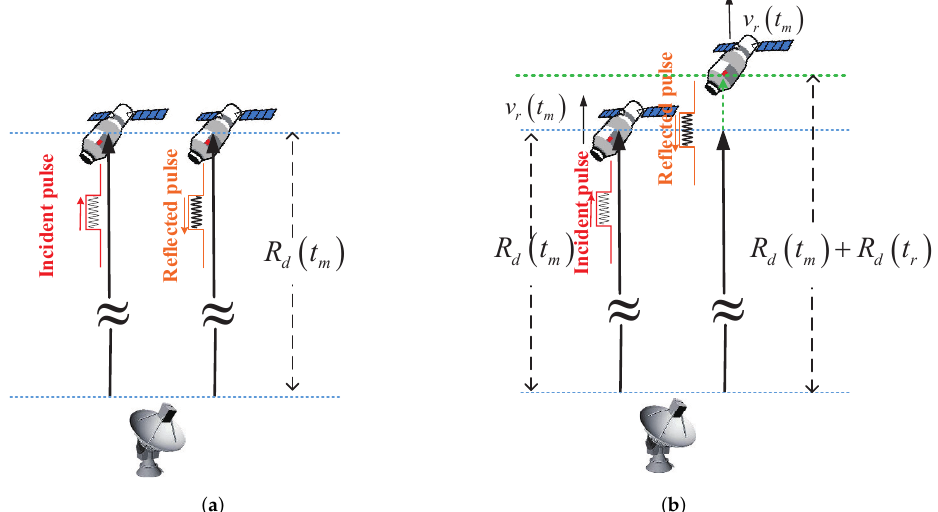
Figure 2. Difference between low-speed moving target and high-speed moving target: ( a ) the low-speed moving target; and ( b ) the high-speed moving